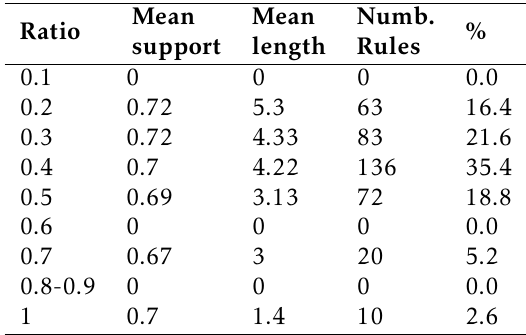
Figure 3. Correlation between R and P (cid:48) representing Words Figure 4. Correlation between R and N (cid:48) representing Words P P with greater affinity to positive diagnosed patients with greater affinity to negative diagnosed patients Table 4. Rule frequency per ratio for negative Table 3. Rule frequency per ratio for positive cases